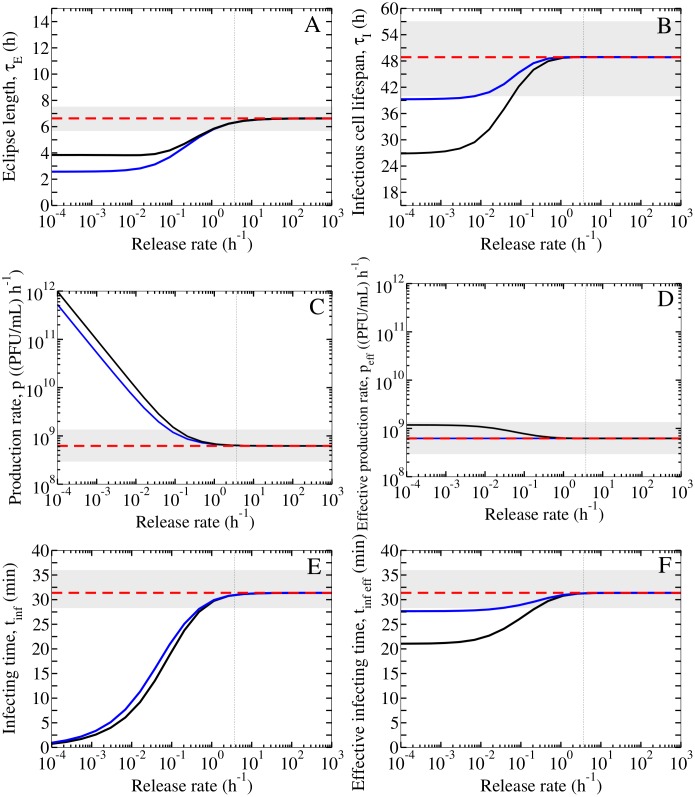
Comparing parameter estimates between the simple MM and release MM.The simple MM base parameters of an in vitro infection with the 2009 pandemic influenza A (H1N1) virus strain [20] are shown (red) with 95% confidence intervals (grey band). For the release MM, the parameter estimates obtained (y-axis) as a function of the viral release rate (x-axis) are shown for the case when all parameters (p, β, c, τE, τI) are estimated (black), or for the case with the constraint prelease = psimple(r + c)/r (blue). The critical free virus release rate, rf = 3.7 h−1, is indicated (vertical dotted line).